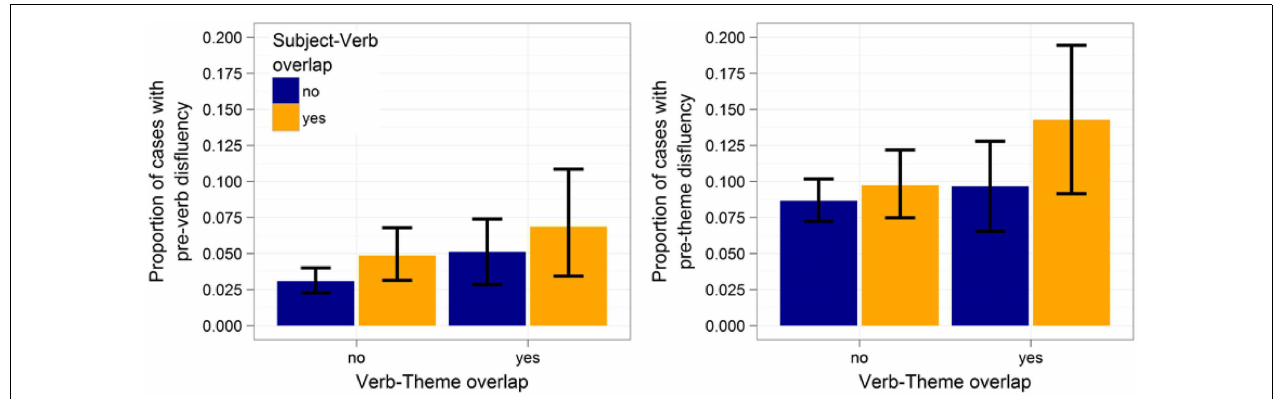
FIGURE 4 | Effects of subject-verb and verb-theme overlap on the likelihood of disfluencies in the pre-verb region (left) and pre-theme region (right). Proportions are out of 2061 cases. Error bars give 95% non-parametric confidence interval (obtained via bootstrap).